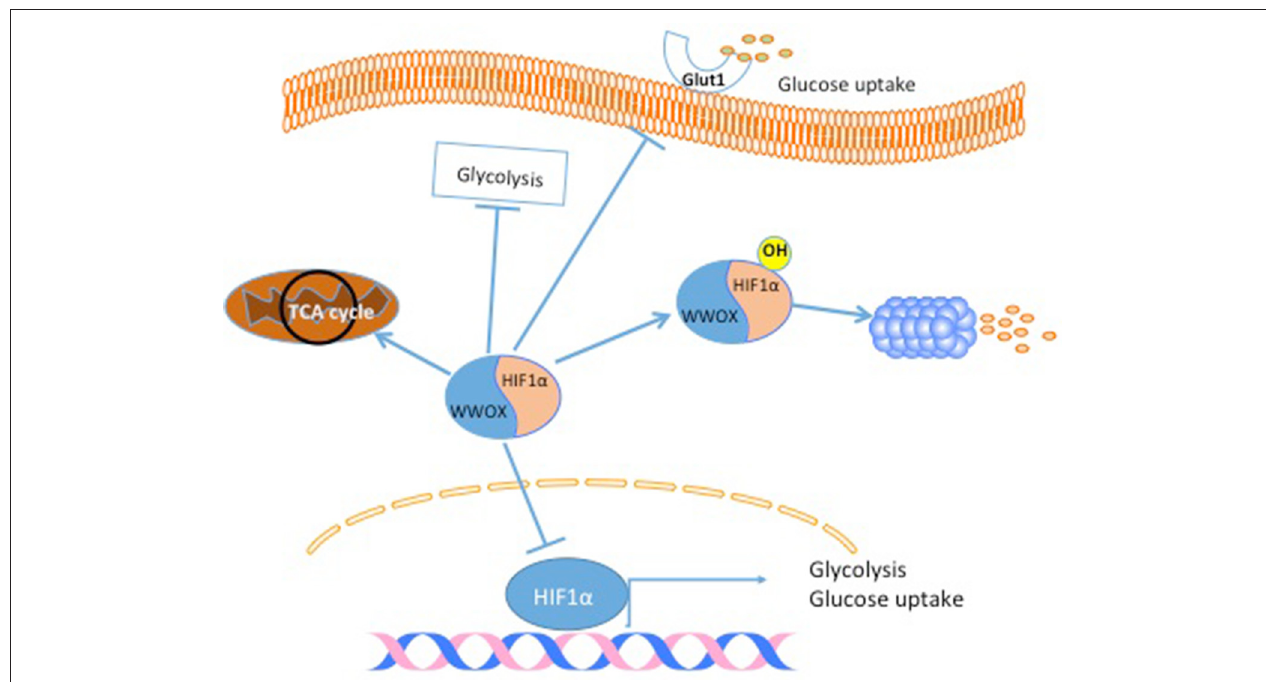
FIGURE 3 | WWOX modulates cancer cell metabolism. When WWOX is present it binds to HIF1 α and inhibits its transcriptional activity. Moreover, WWOX increases HIF1 α hydroxylation and increase its degradation. As a consequence WWOX reduces glucose uptake, decreases glycolysis and increase mitochondrial